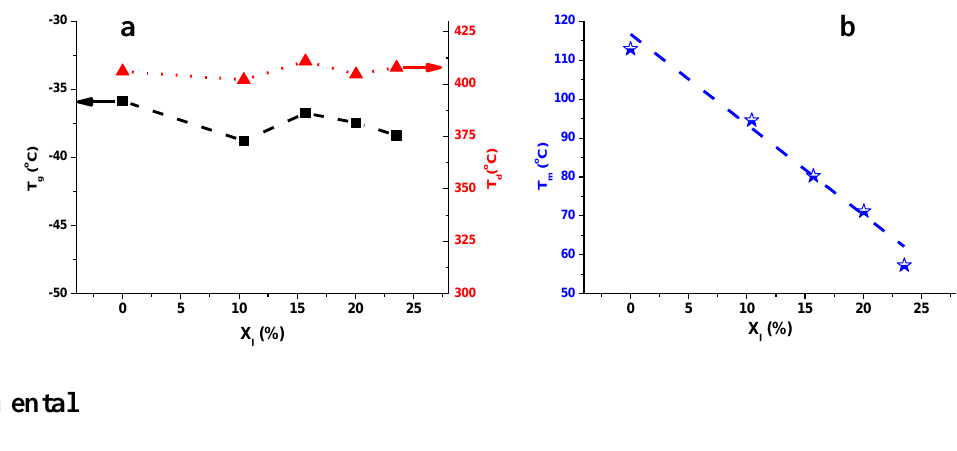
Figure 8. ( a ) the T and T of PBSI as a function of the mole percentage of itaconate (X g d ( b ) the T of PBSI as a function of the mole percentage of itaconate (X m synthesized via the optimal